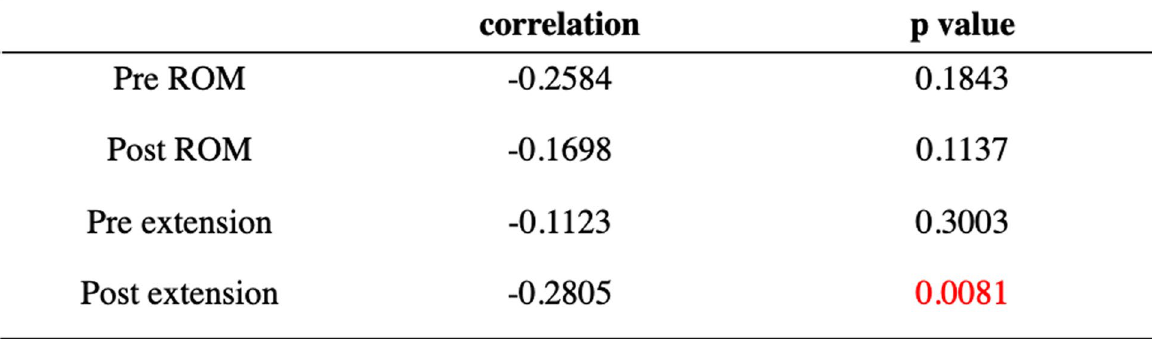
ROM range of motion (flexion –